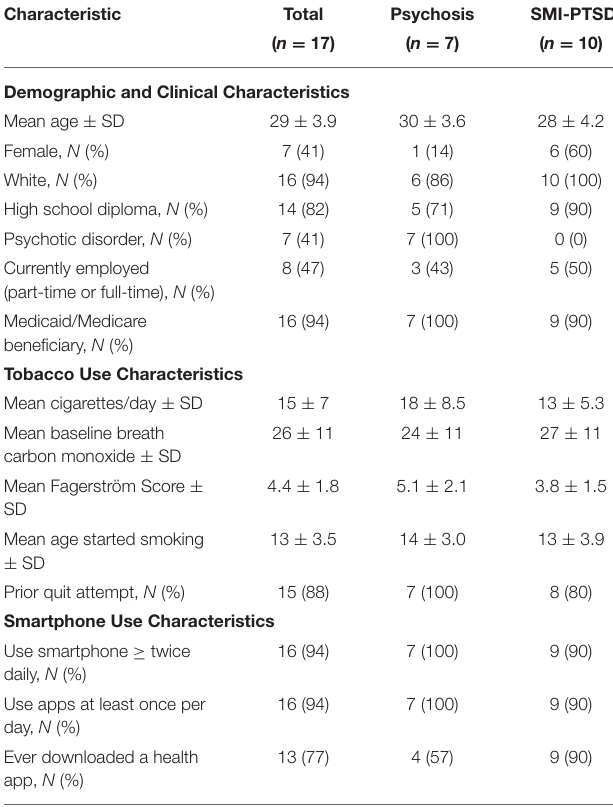
TABLE 2 | Participant